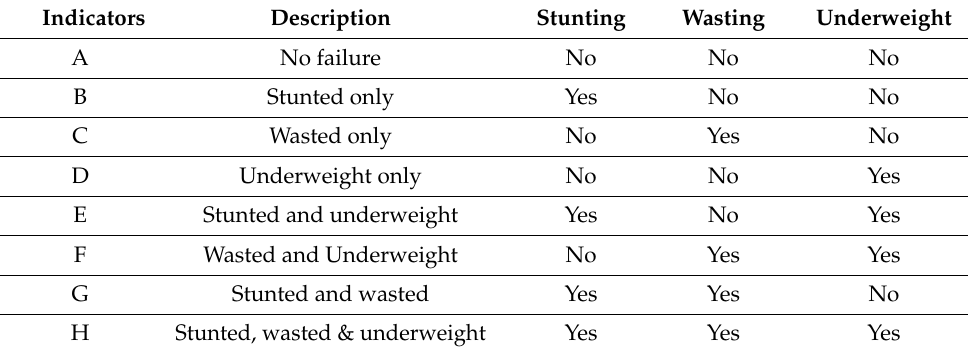
Table 2. Children’s CIAF classification with anthropometric